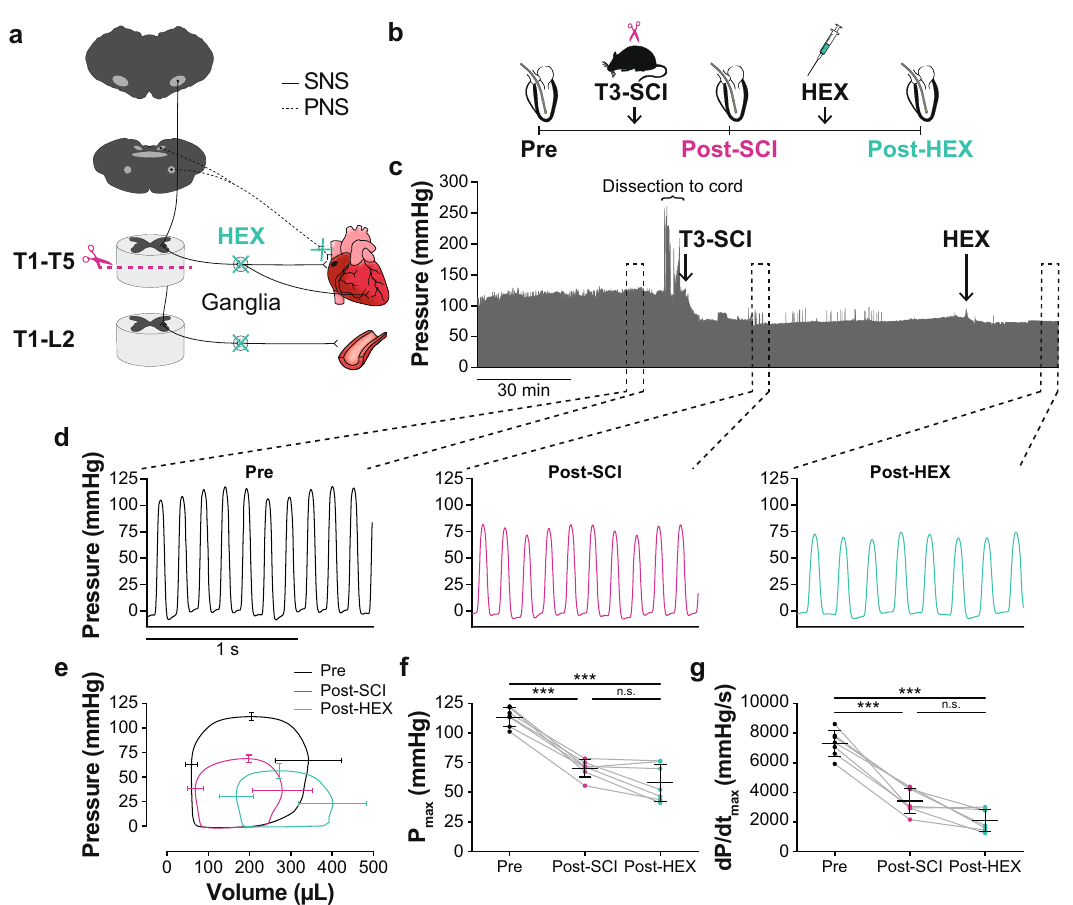
Fig. 6 Effects of a T3 complete transection SCI (T3-SCI) and ganglionic blockade with hexamethonium (HEX) on catheter-derived LV functional outcomes in rats. a Neuroanatomical representation of study design and interventions. b Methods timeline (longitudinal): Male Wistar rats (10 – 11 wks of age) underwent fi rst LV catheterization to record pressure-volume data, second a T3-SCI, and last an intravenous HEX infusion (20 mg/kg). c